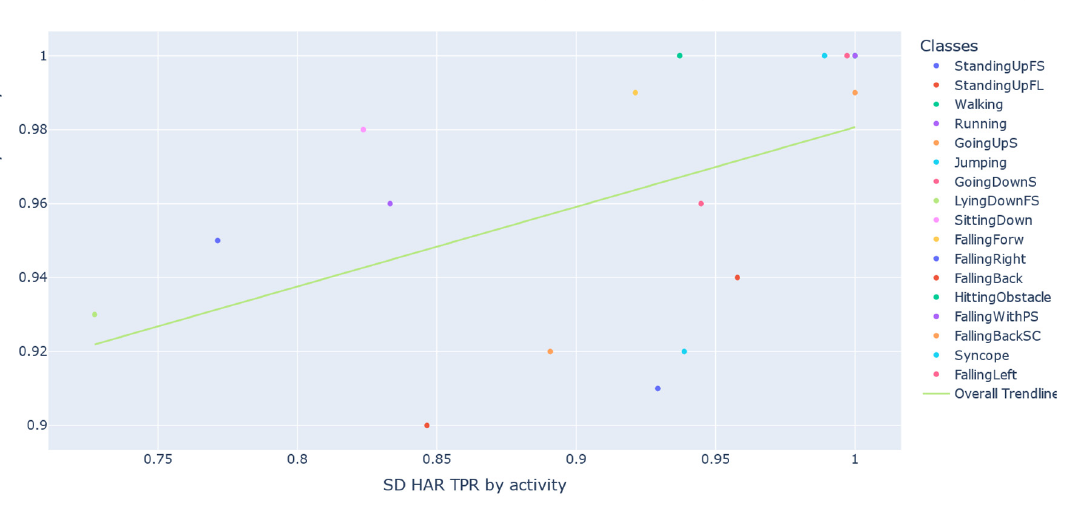
Figure 12. Correlation between the performance of user identification and SD HAR.